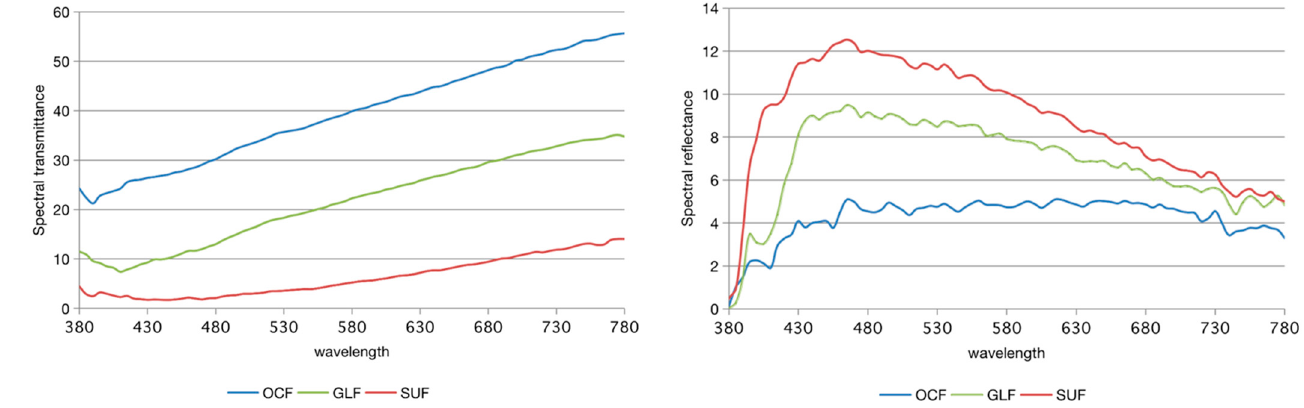
Figure 3. Distribution of spectral transmittance and spectral reflectance of each of the tested flowable resin composites.